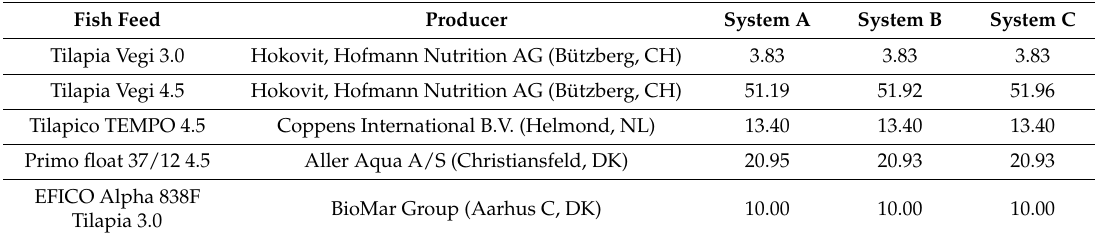
Table A2. Fish feed (in kilograms) fed to tilapia during the experiment.